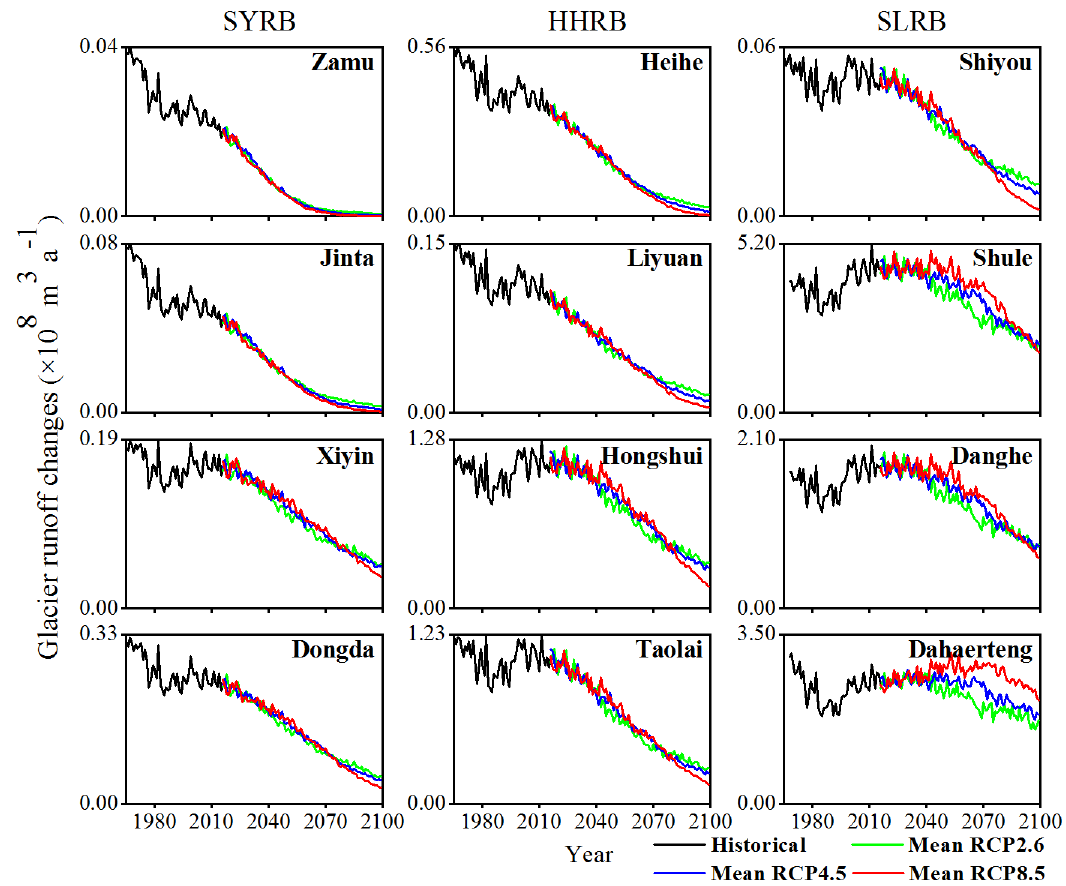
Figure 7. The area changes of total glacier melt runoff in each subbasin from 1965–2100. The four pictures in each column show subbasins in the same basin, including the SYRB, HHRB and SLRB. In each subbasin, the black line represents the historical changes in glacier runoff from 1965~2016; the colored lines represent the future changes in glacier runoff under different GCMs from 2016~2099; among them, the red line shows the changes in the mean value under RCP2.6, the blue line shows the changes in the mean value under RCP4.5 and the red line shows the changes in the mean value under RCP8.5.